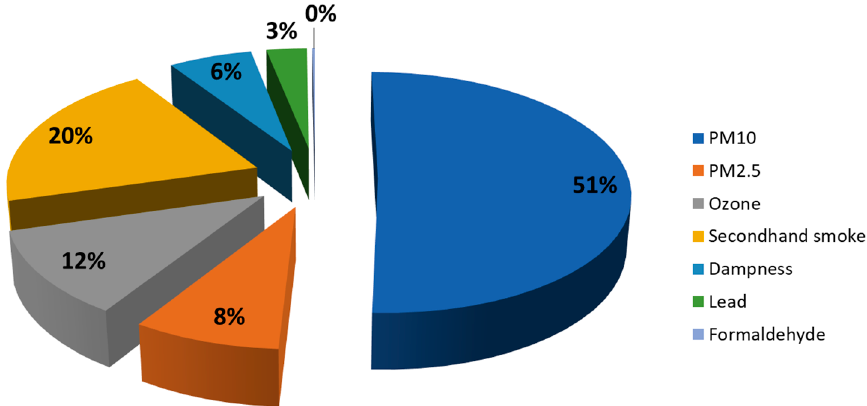
Figure 1. Percentage of exposures studied that contribute to the environmental burden of disease in EU28, in the population less than 18 years old. PM 10 : particulate matter less than 10 micrometers of diameter; PM 2.5 : particulate matter less than 25 micrometers of diameter.